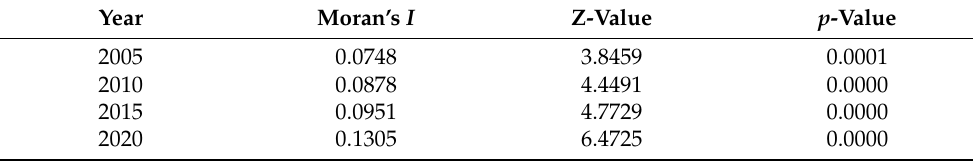
Table 3. Four-year global autocorrelation Moran’s I and Z values for GLUEUL in